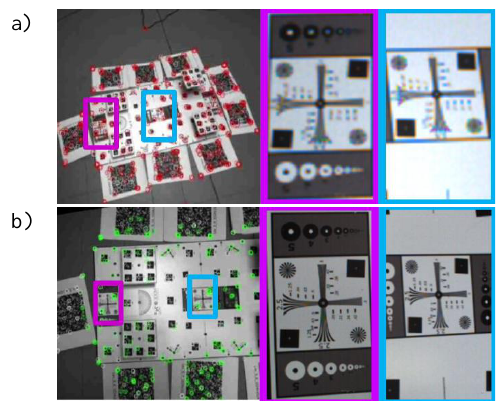
Figure 6. Example of real-time GSD feedback where red tie points (a) become green (b) once the agent gets to the proper distance to meet the planned GSD (in this example about 2 mm) as verified using the resolution wedges of the testfield (Torresani et al., 2021).